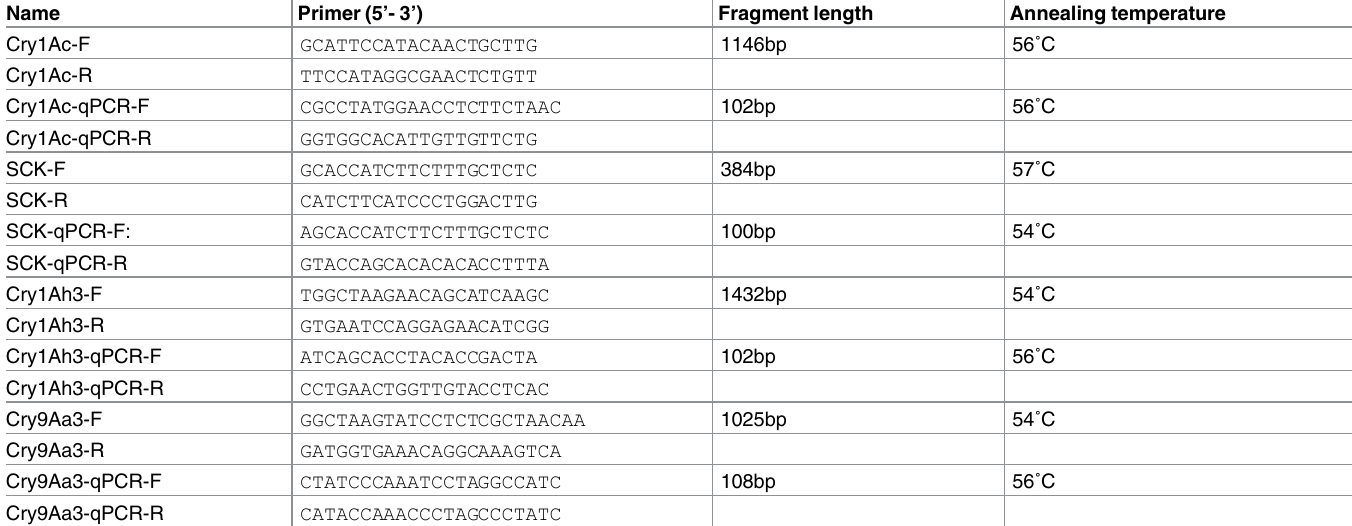
Table 1. Primers for PCR and